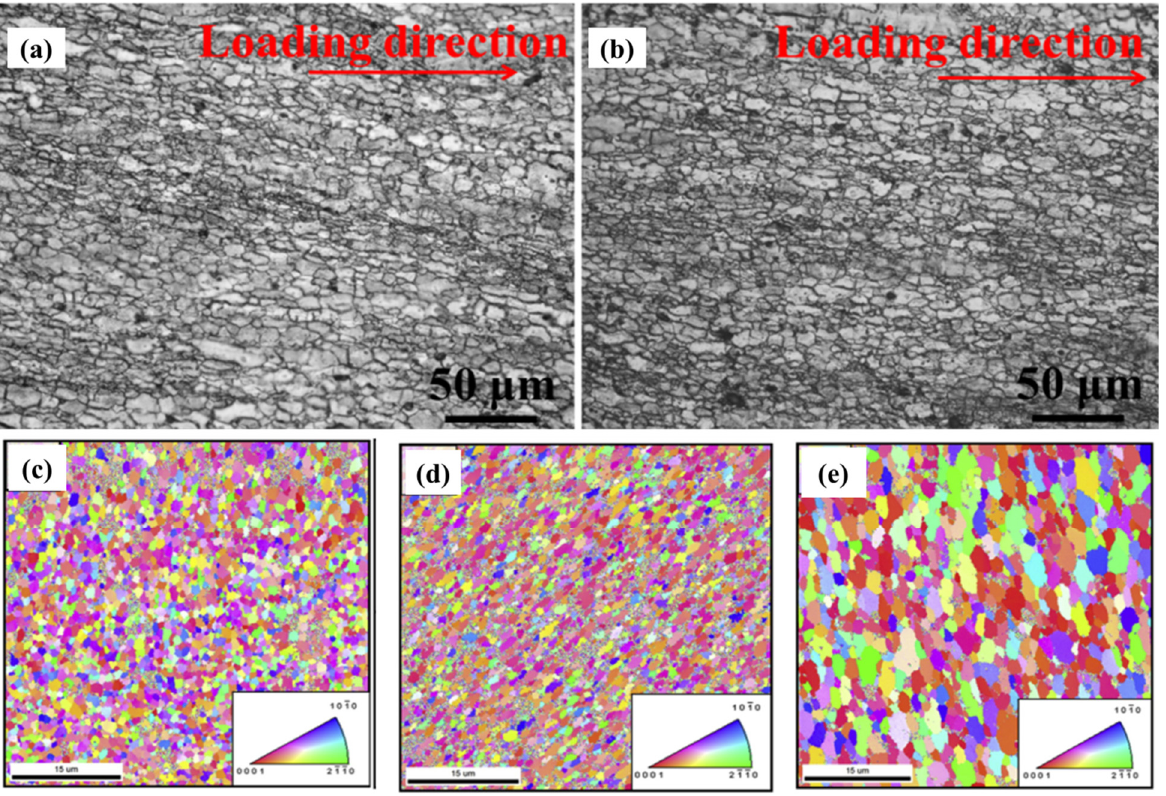
Figure 5. IPF maps and OM micrographs: ( a , b ) OM micrographs of extruded ZK60 at 350 and 400 °C [15]; ( c ) IPF maps of as received QE22 Mg alloy; ( d , e ) IPF maps at temperature 350 °C under strain rate of 0.01 s − 1 and 0.003 s − 1 , respectively [39].